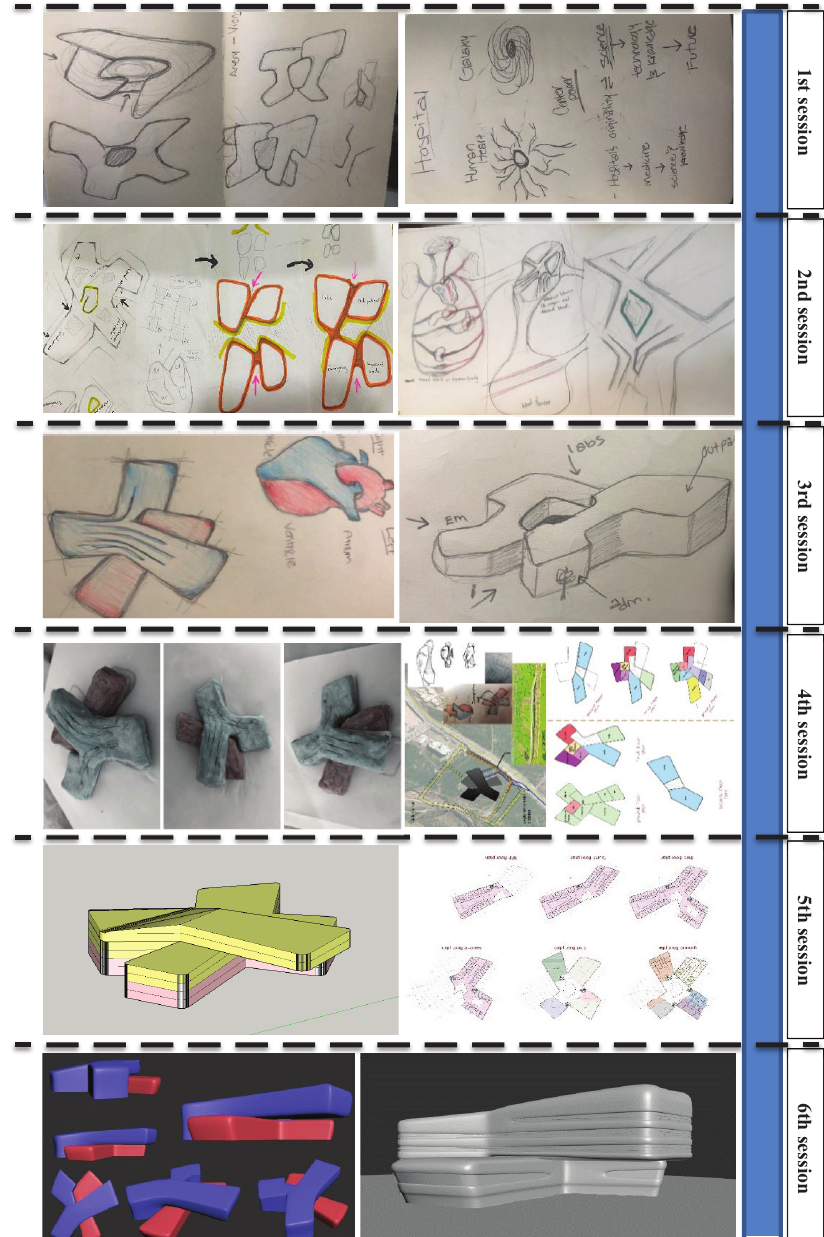
Fig. 1. A conceptual design phase breakdown of a student (ID: 16) and the concept transformations during the six design sessions (Researcher)